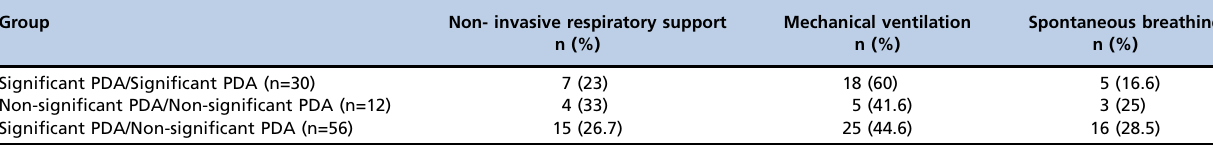
Table 2 - Respiratory statuses of enrolled infants on day 4 of